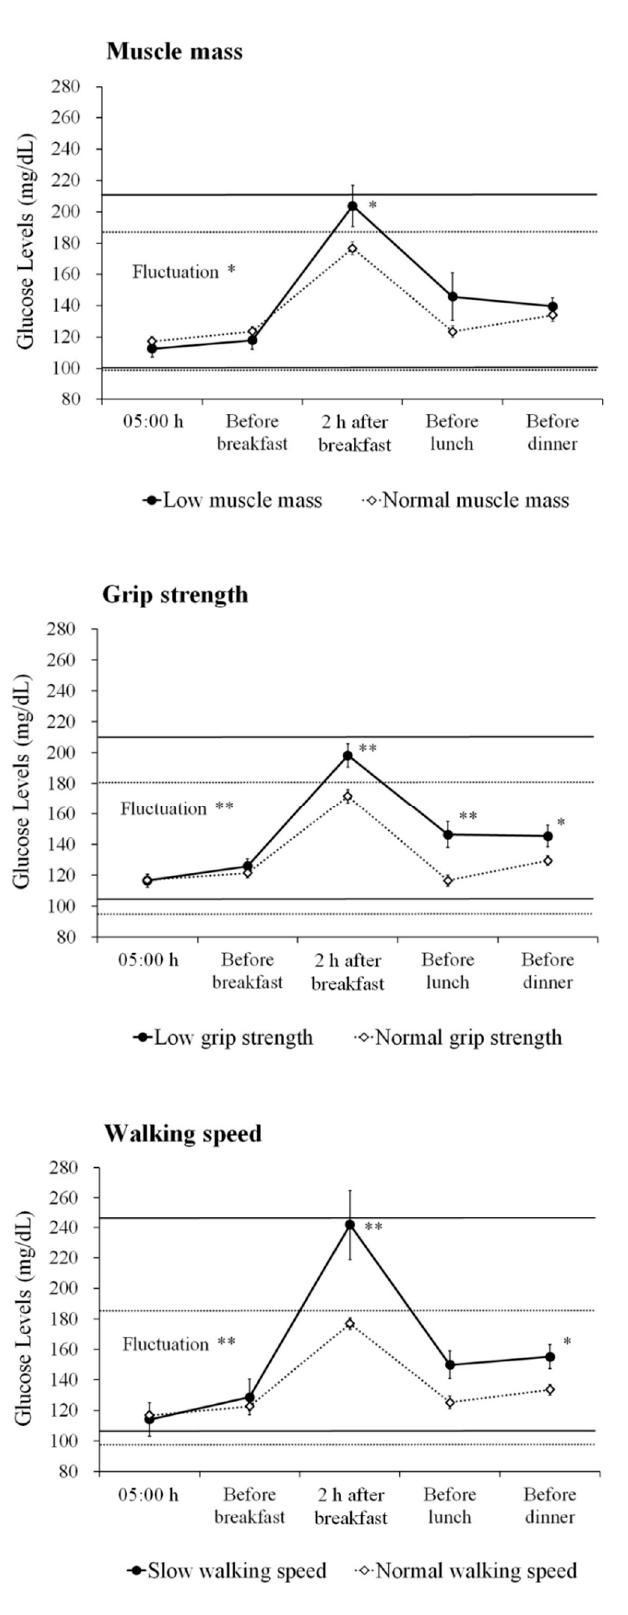
Figure 2. Daily glucose profiles based on the sarcopenia components. The figures show the average ± SE glucose level based on the components of sarcopenia in all participants. ** p < 0.01, * p < 0.05.